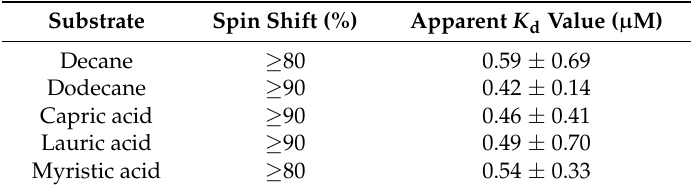
Figure 2. Spectral shift and titration curves of various alkanes and fatty acids. Differences in absorption were observed between A 390 and A 420 upon the addition of different concentrations ( µ M) of substrates and the fitted trace from which the K d value was determined. ( A ) Substrate-induced spin state shifts of a CYP153D17 substrate-free (solid line) and dodecane-bound (dotted line); ( B ) C10 alkane, decane; ( C ) C12 alkane, dodecane; ( D ) C10 fatty acid, capric acid; ( E ) C12 fatty acid, lauric acid; ( F ) C14 fatty acid, myristic acid. Table 1. Binding Constants of Purified CYP153D17 with Various Alkanes and Fatty Acids.